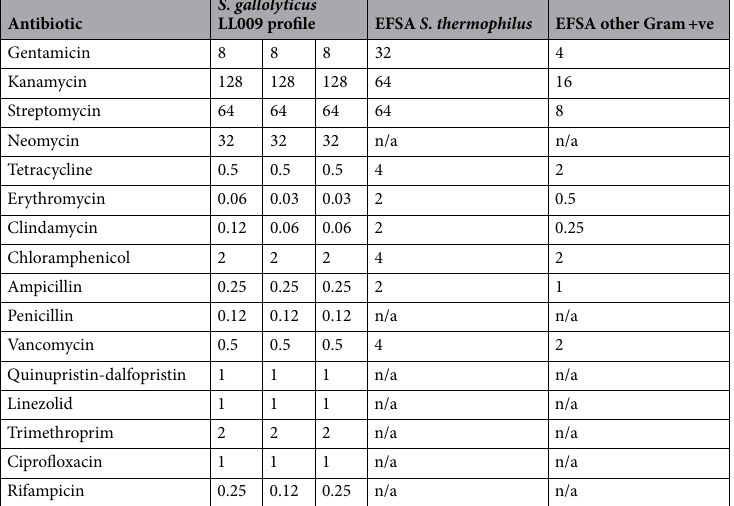
Table 1. Antibiotic resistance results. EFSA guidelines do not have specific values for S. gallolyticus. Values for S. thermophilus and the defined values for “other Gram positive” bacteria